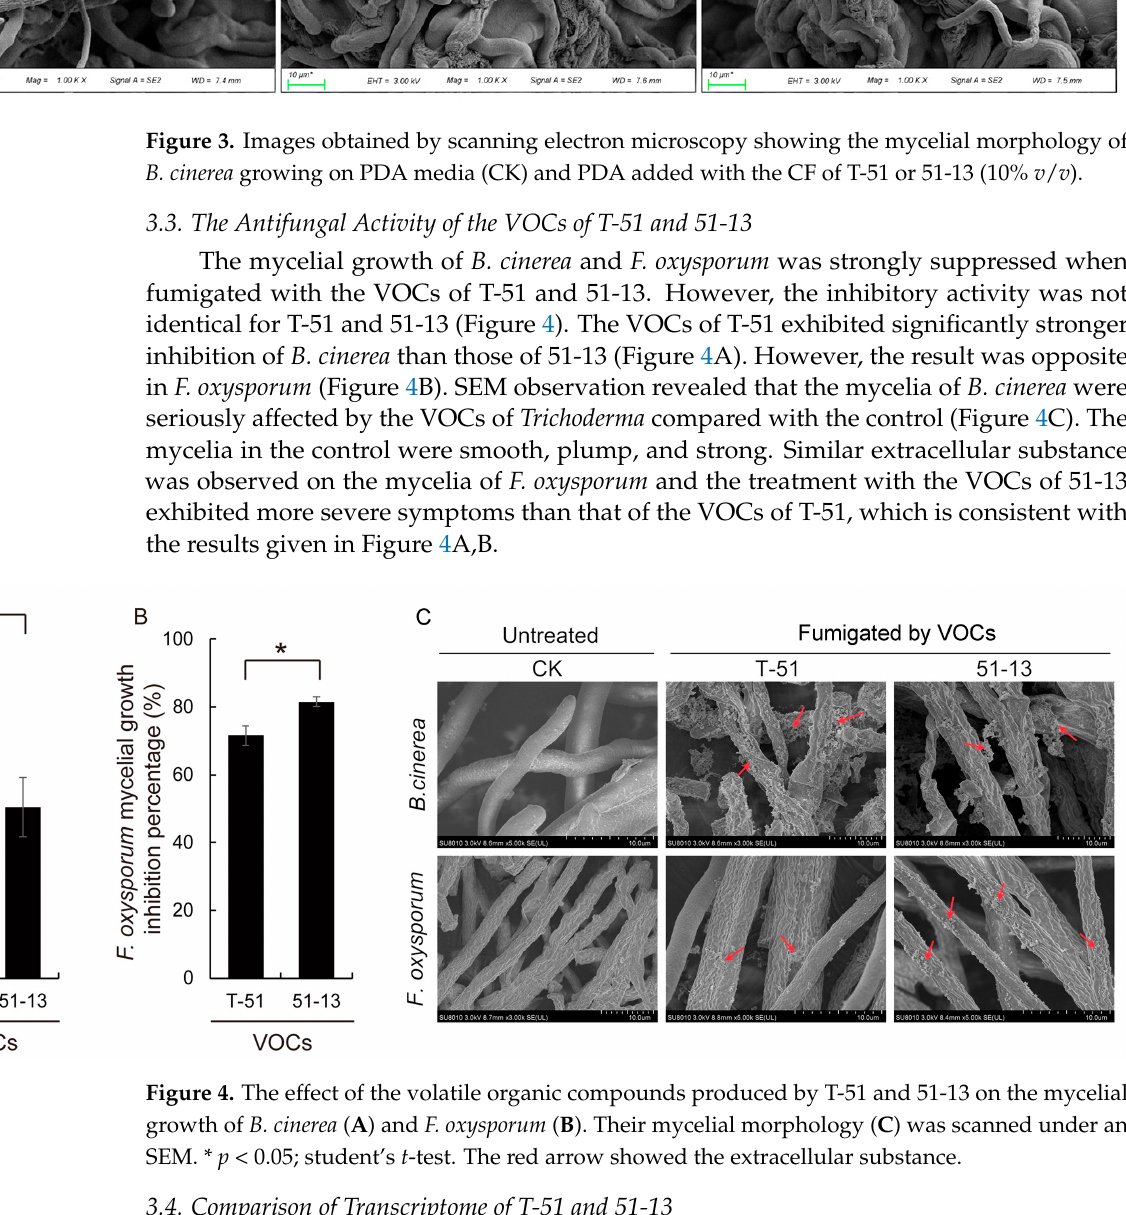
Figure 4. The effect of the volatile organic compounds produced by T-51 and 51-13 on the mycelial growth of B. cinerea ( A ) and F. oxysporum ( B ). Their mycelial morphology ( C ) was scanned under an SEM. * p < 0.05; student’s t -test. The red arrow showed the extracellular